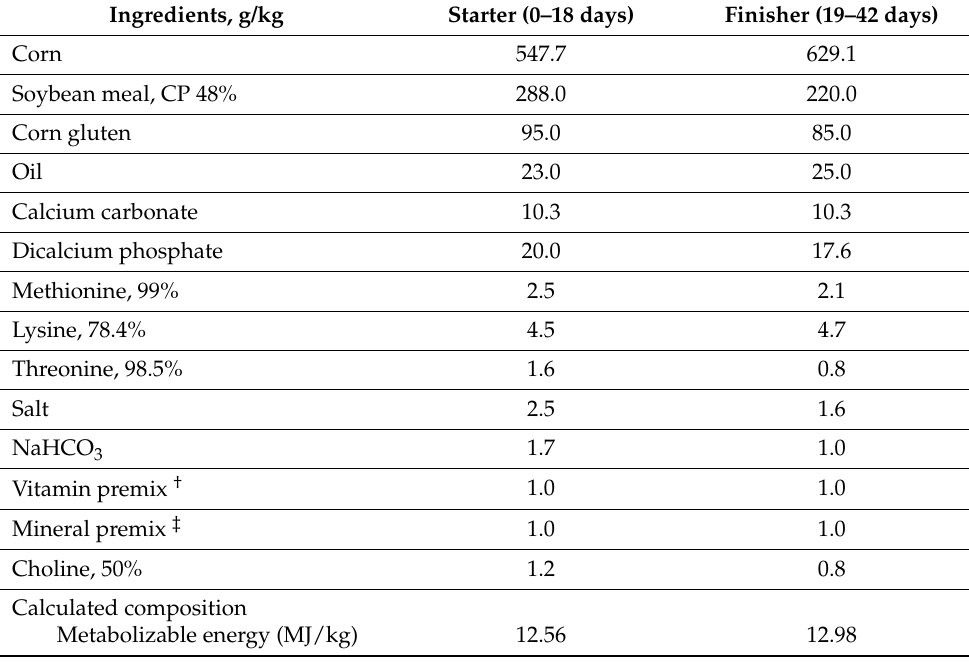
Table 1. Ingredient composition of experimental diets (as-fed basis). Ingredients,